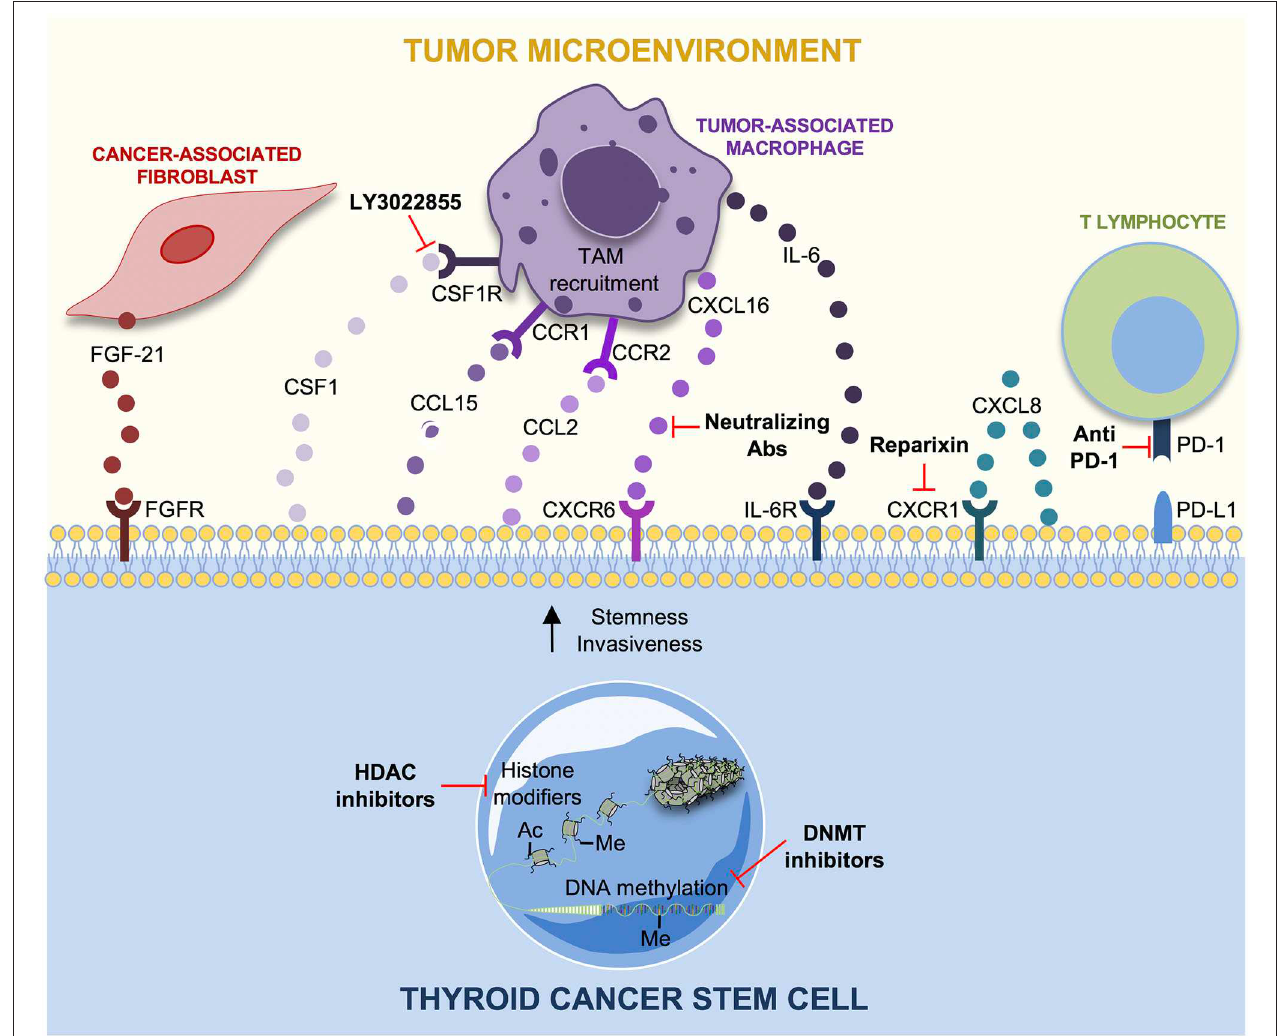
FIGURE 4 | Tumor microenvironment (TME) interactions and therapeutic strategies in thyroid cancer stem cells (TCSCs). The principal interactions between TCSCs and tumor microenvironment (TME) cells, along with the novel potential therapeutic targets, are shown. Cancer-associated fibroblasts (CAFs) produce FGF-21, which favors a more aggressive TC cells phenotype. TC cells secrete chemokines as CSF1, CCL15, and CCL2 to recruit tumor-associated macrophage (TAM) in order to sustain TC progression. CXCL8 secreted by TC cells guarantees stemness through an auto-paracrine loop by binding CXCR1. CXCL16 is secreted by TAMs favoring the migration and invasiveness of TC cells. Interleukin-6 (IL-6) supports stemness, colony formation and proliferation, in TC cells through JAK1/STAT3 phosphorylation. Reparixin (CXCR1 inhibitor) decreases thyrospheroid survival and epithelial–mesenchymal transition (EMT). The use of the CSFR1 inhibitor, LY3022855, hampers TAM recruitment. CXCL16-neutralizing antibody counteracts TC progression. Immunotherapy is based on the use of anti-PD1 antibodies as Pembrolizumab and Nivolumab, whereas epigenetic therapy nowadays is limited to histone deacetylase (HDAC) and DNA methyltransferase (DNMT) inhibitors alone or in combination with conventional approaches in